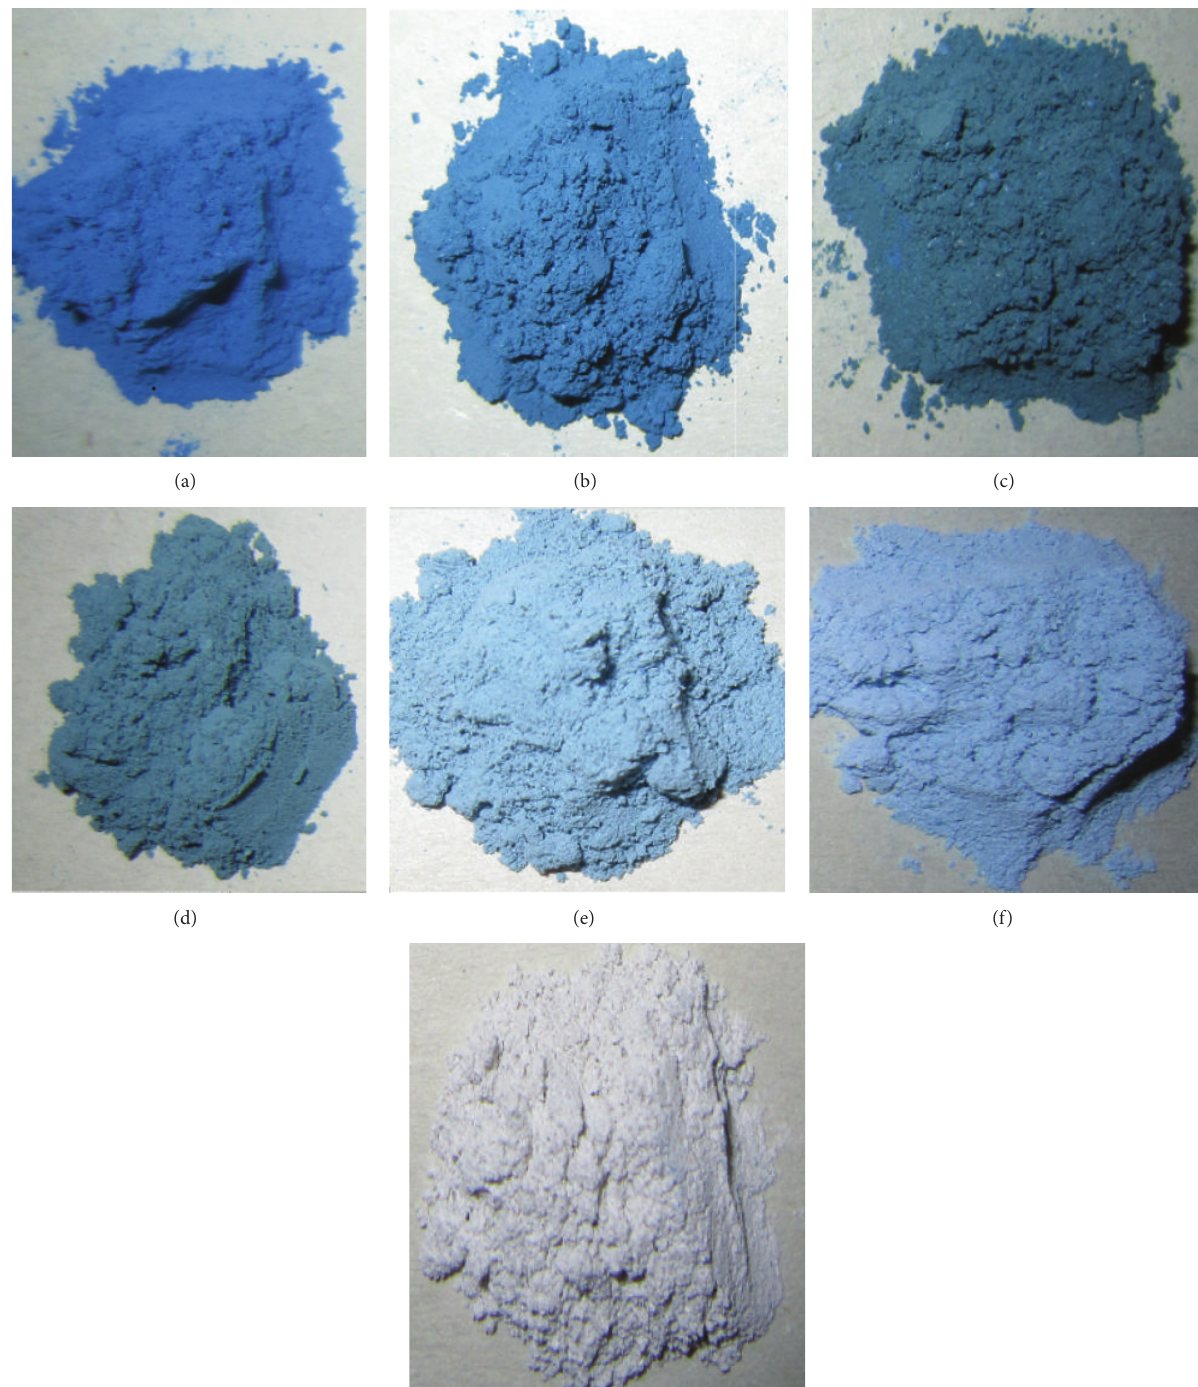
Figure 2: Various colors for Co